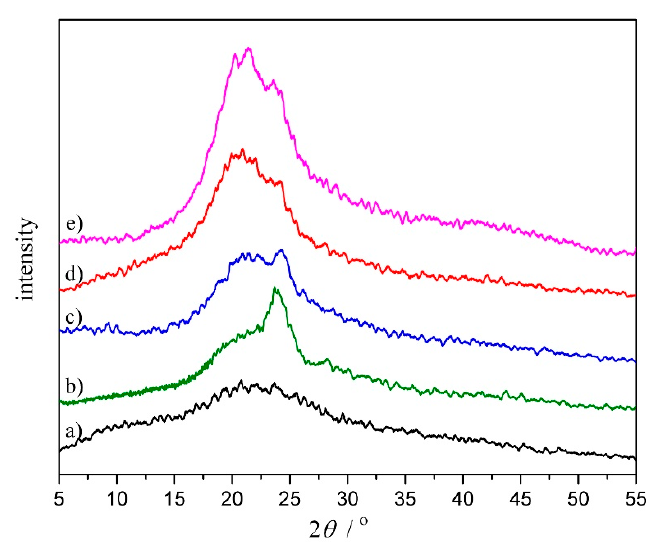
Figure 5. XRD patterns of ( a ) COS powder; ( b ) CPU-1.0; ( c ) CPU-1.4; ( d ) CPU-1.7 and ( e ) CPU-2.0 films.